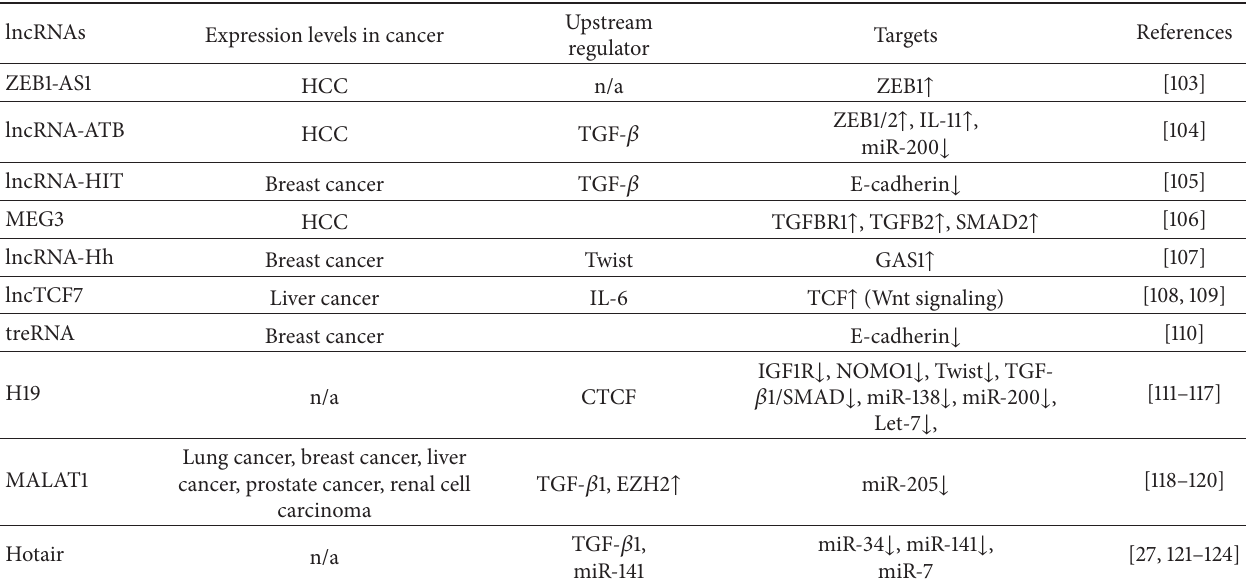
Table 2: lncRNAs and EMT.